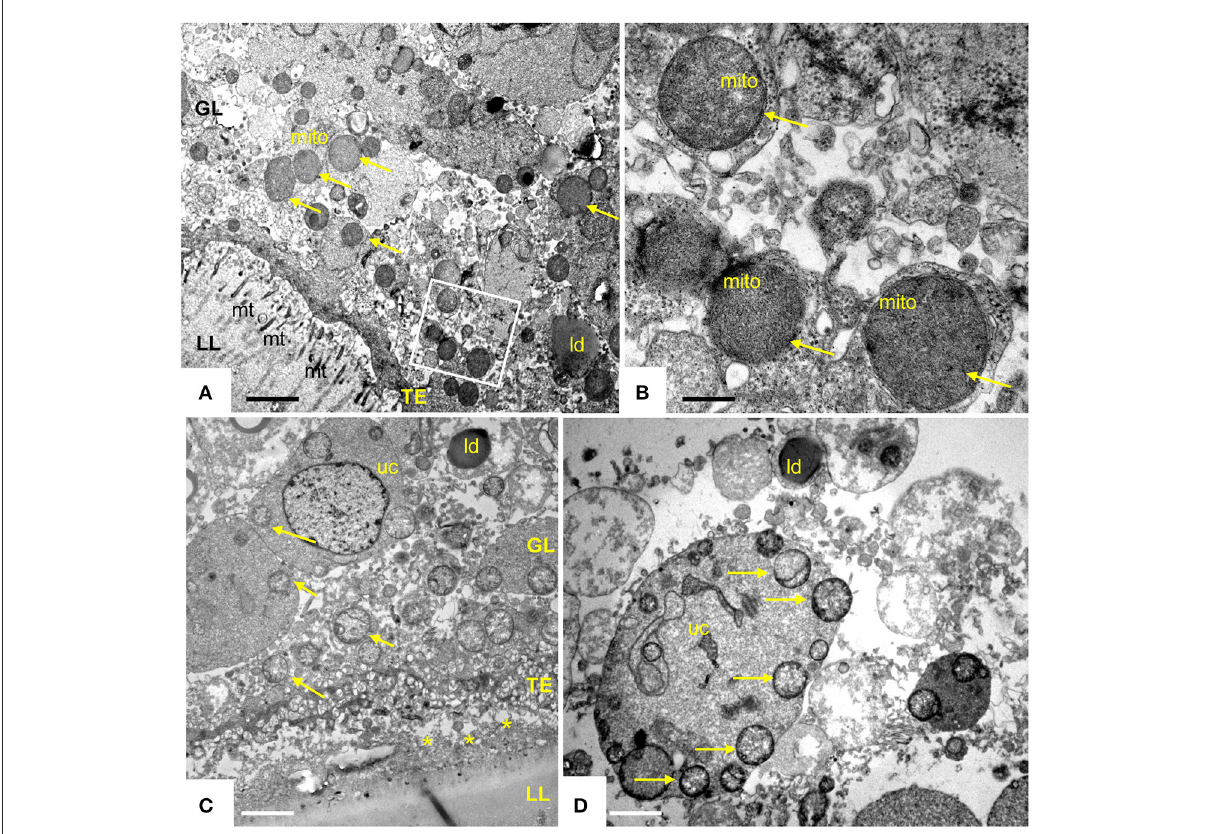
FIGURE3 Transmission electron microscopy (TEM) of E. multilocularis metacestodes treated with 1 and 2 µ M ELQ-400. TEM of metacestode tissue treated with 1 µ M (A,B) and 2 µ M (C,D) of ELQ-400 under normoxic (21% O 2 ) conditions. The boxed area in (A) is shown at higher magnification in (B) . Mitochondria (mito) are rounded, progressively less electron dense, on both the GL tissue [ (C) as well as in undifferentiated cells (uc)] (D) , as indicated by the arrows; * indicates separated LL and GL; mt, microtriches; ld, lipid droplet. Bars in (A) = 1.2 µ m; (B) = 0.28 µ m; (C) = 2.2 µ m; (D) = 1.8 µ